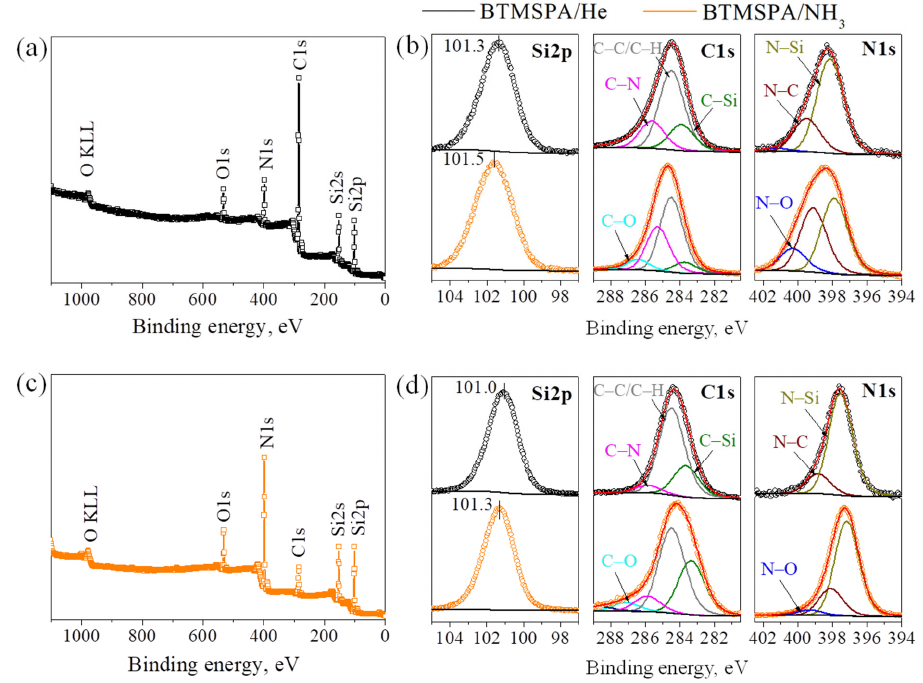
Figure 3. Full-range XPS spectra of SiCN films deposited at 400 ◦ C using BTMSPA/He ( a ) or Figure 3. Full ‐ range XPS spectra of SiCN films deposited at 400 °C using BTMSPA/He ( a ) or BTMSPA/NH 3 ( c ) mixtures, and Si2p, C1s, N1s core-level spectra of SiCN films deposited at 100 ◦ C BTMSPA/NH 3 ( c ) mixtures, and Si2p, C1s, N1s core ‐ level spectra of SiCN films deposited at 100 °C ( b ) and 400 °C ( d ) using BTMSPA/He (black) or BTMSPA/NH 3 (orange) mixtures. ( b ) and 400 ◦ C ( d ) using BTMSPA/He (black) or BTMSPA/NH 3 (orange)